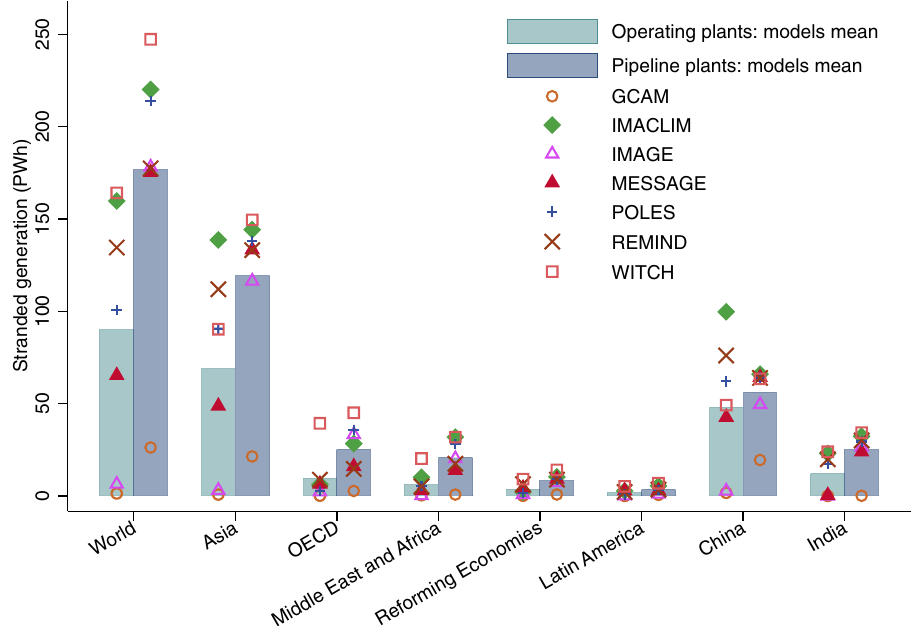
Fig. 2 Estimated stranded generation in all technologies deployed scenarios (2021 – 2100). Total stranded generation of fossil fuel power plants (including coal-, gas- and oil- fi red) from 2021 to 2100 in all technologies deployed scenarios of AMPERE consistent with greenhouse gas concentrations stabilise at 450 ppm. Stranded generation are computed by fuel and then aggregated. We assume no conversion of the currently operating and in-the-pipeline fossil- fuel power plants to be equipped with carbon capture and storage, and no conversion of the currently operating and in-the-pipeline coal- fi red power plants to bioenergy or gas. Scatter points represent the estimation from individual integrated assessment model and bars show the means across all